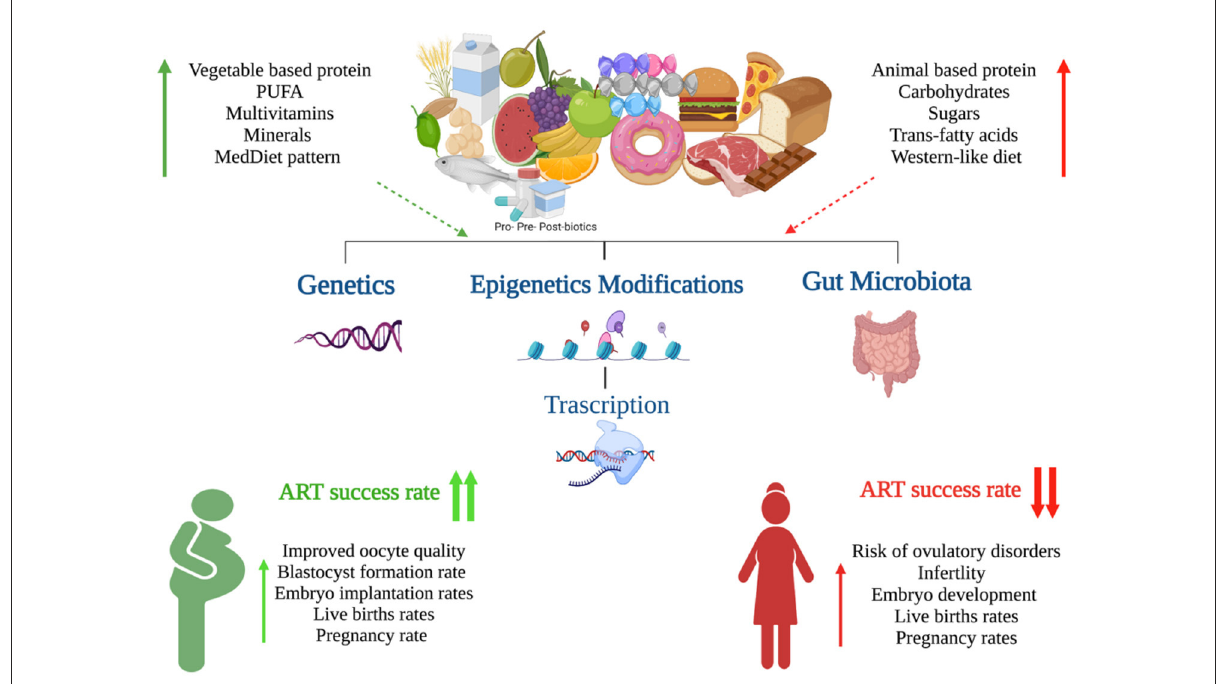
FIGURE1 Graphical summary of the impact of nutrition on female fertility (Created with